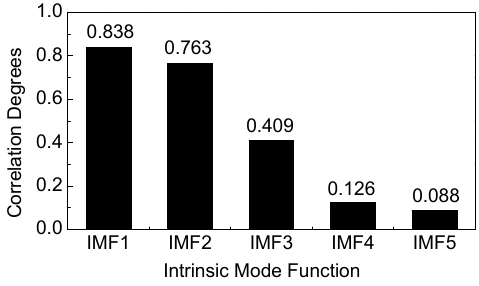
Figure 14. Correlation values of respective IMF components from the denoised signal.